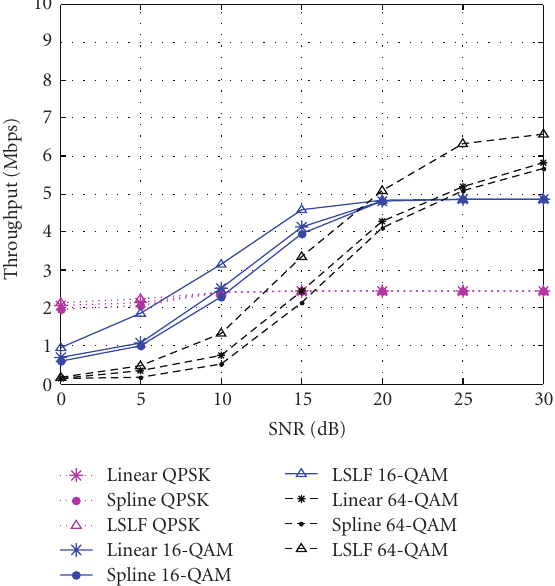
Figure 11: Throughput in Veh.A 30 km/h without using channel tracking.